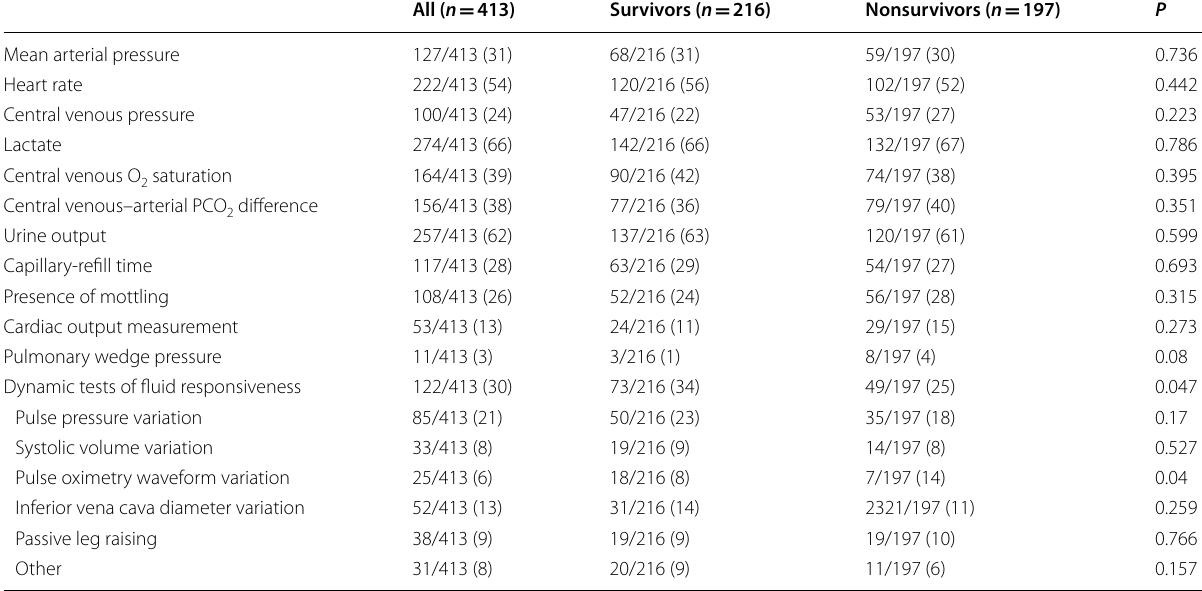
Data are shown as number (percentage)